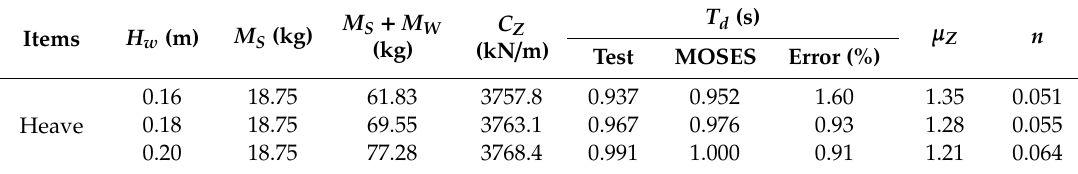
Table 3. Added mass and damping of heaving motion.